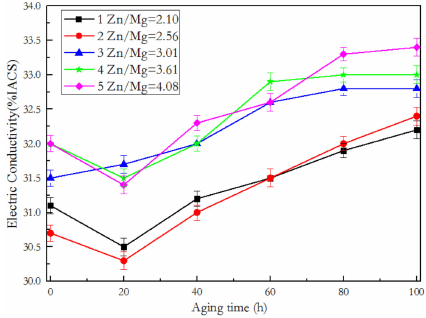
Figure 2. The conductivity curves of the alloys during isothermal aging at 120 ◦